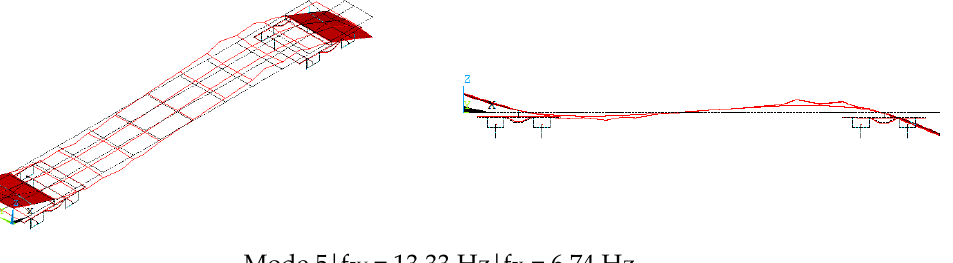
Figure 11. Numerical modal parameters before calibration (undeformed mesh in grey and deformed mesh in red). The modal configurations involve structural movements of the vehicle platform, namely bending and torsion, which in some of the cases, are coupled with specific rigid body movements particularly the rolling, bouncing and pitching. The presented mode shapes (1 to 5) are correspondent to the ones experimentally identified according to Figure 9. It should be noted that the order of the numerical modes is different from the order of the experimental modes, particularly in the case of Modes 2 and 3 for the unloaded con- figuration. 5. Calibration The calibration of the numerical model of the Sgnss wagon was based on the results of the dynamic tests and involved a sensitivity analysis and an optimization based on a genetic algorithm. The automatic mode pairing between the numerical and experimental modes was performed based on the modal assurance criterion (MAC) [57]. The calibration was performed sequentially, first for the unloaded wagon model and then for the loaded wagon model. A correlation analysis allowed a comparison between the modal parame- ters obtained. 5.1. Sensitivity Analysis The sensitivity analysis allowed for the selection of the numerical parameters that most influence the modal responses (five natural frequencies and five modal configura- tions) and so should be included in the subsequent optimization phase. In this study, 10 numerical parameters were selected and stochastically sampled by the Latin hypercube method. The samples generated based on uniform distributions within the limits of each parameter are given in Table 2. The sensitivity analysis results are based on Spearman correlation coefficients ( e ) that express the monotonic correlation between two vectors of samples, x and y , based on their rank-order vectors, R ( x i ) and R ( y i ), by the expression: